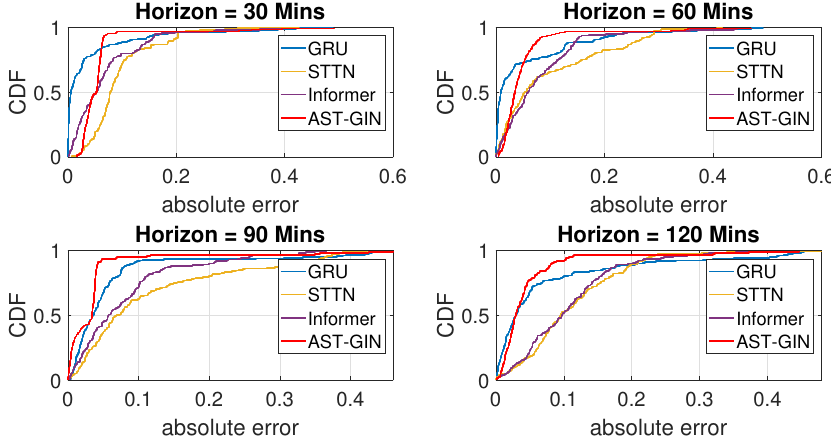
Figure 8. Cumulative distribution function of the absolute error by each